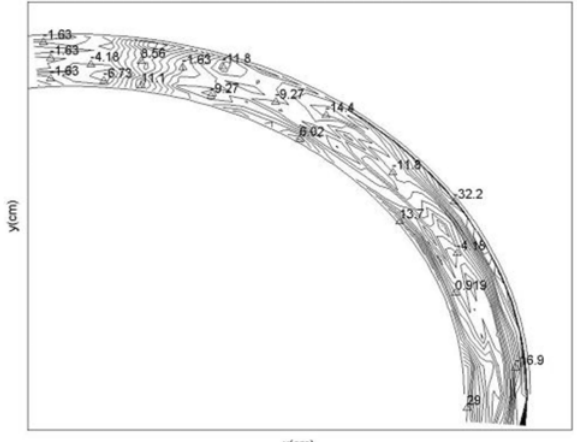
Fig. 8. Bed topography of 900-bend without vanes installation.